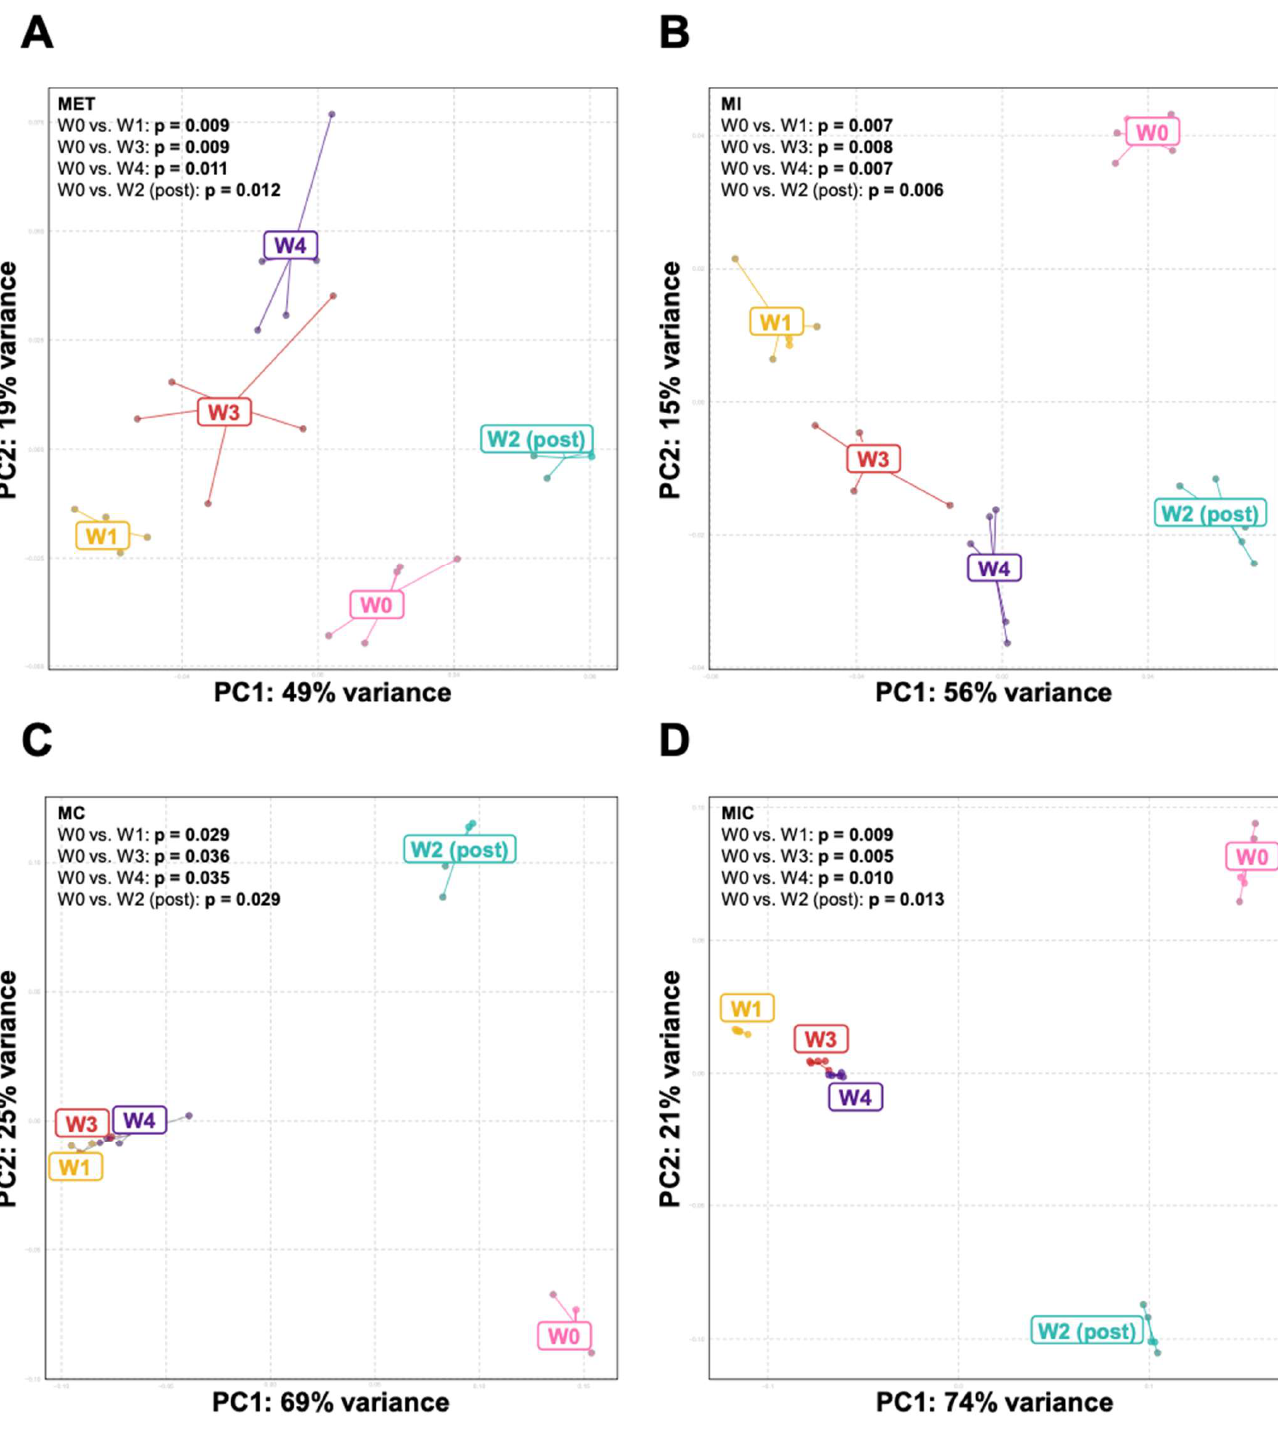
Figure 3. Principal coordinate analysis plot of weighted Unifrac distances in mice treated with ( A ) metronidazole, ( B ) metronidazole + imipenem, ( C ) metronidazole + clindamycin, and ( D ) metronidazole + imipenem + clindamycin. p- values are based on PERMANOVA analysis. n = 4–5 mice/group. PC: principal coordinate.